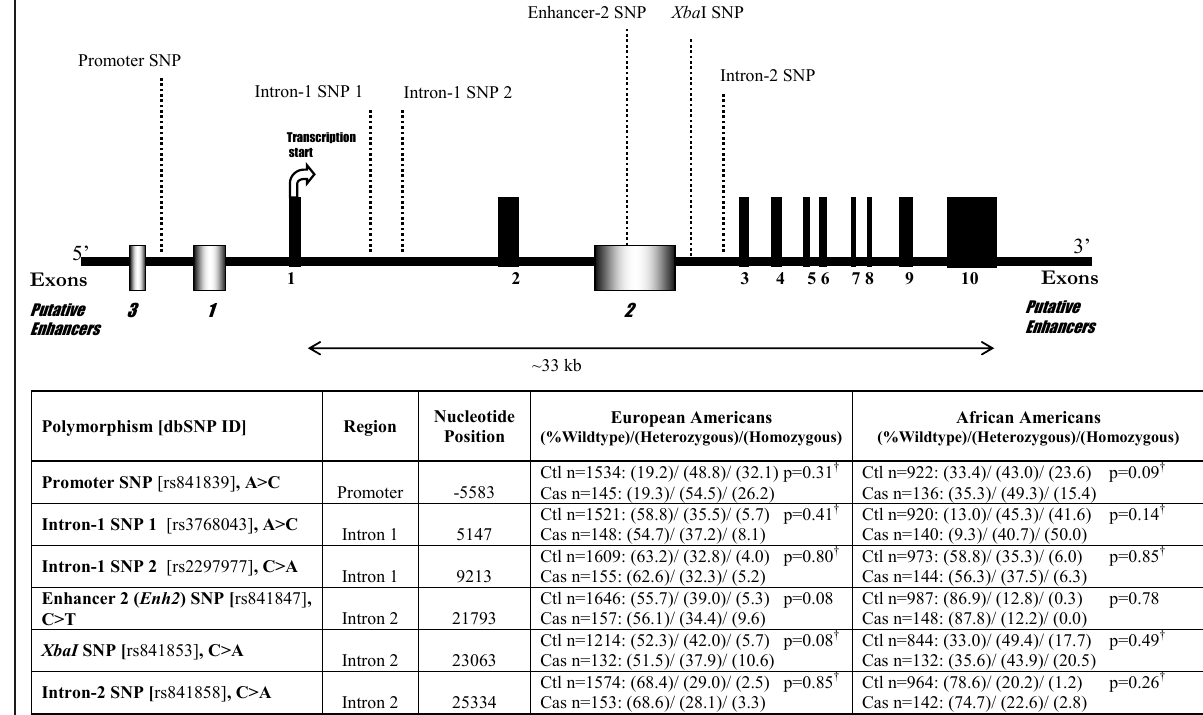
Figure 1 GLUT1 is located on chromosome 1p34.2 . The genomic structure of GLUT1 is illustrated with its 10 exons and three putative enhancers[5]. Genotyped polymorphisms located in intron 2 include the intron-2 SNP (rs841858), and the Enh2 (rs841847) and XbaI (rs841853) SNPs which have been previously associated with diabetic nephropathy[5-7]. In the distal promoter region, the Promoter SNP (rs841839) was genotyped (located between putative enhancers 3 and 1). We also included two SNPs in intron 1, intron-1 SNP(rs3768043) and intron-2 SNP (rs2297977). No SNP was associated with albuminuria among all African Americans or among all European Americans, including XbaI (p = 0.08) and Enh2 (p = 0.08). None of the tagging SNPs were able to reach a Bonferroni adjusted level of statistical significance. † Bonferroni corrected level of statistical significance p =